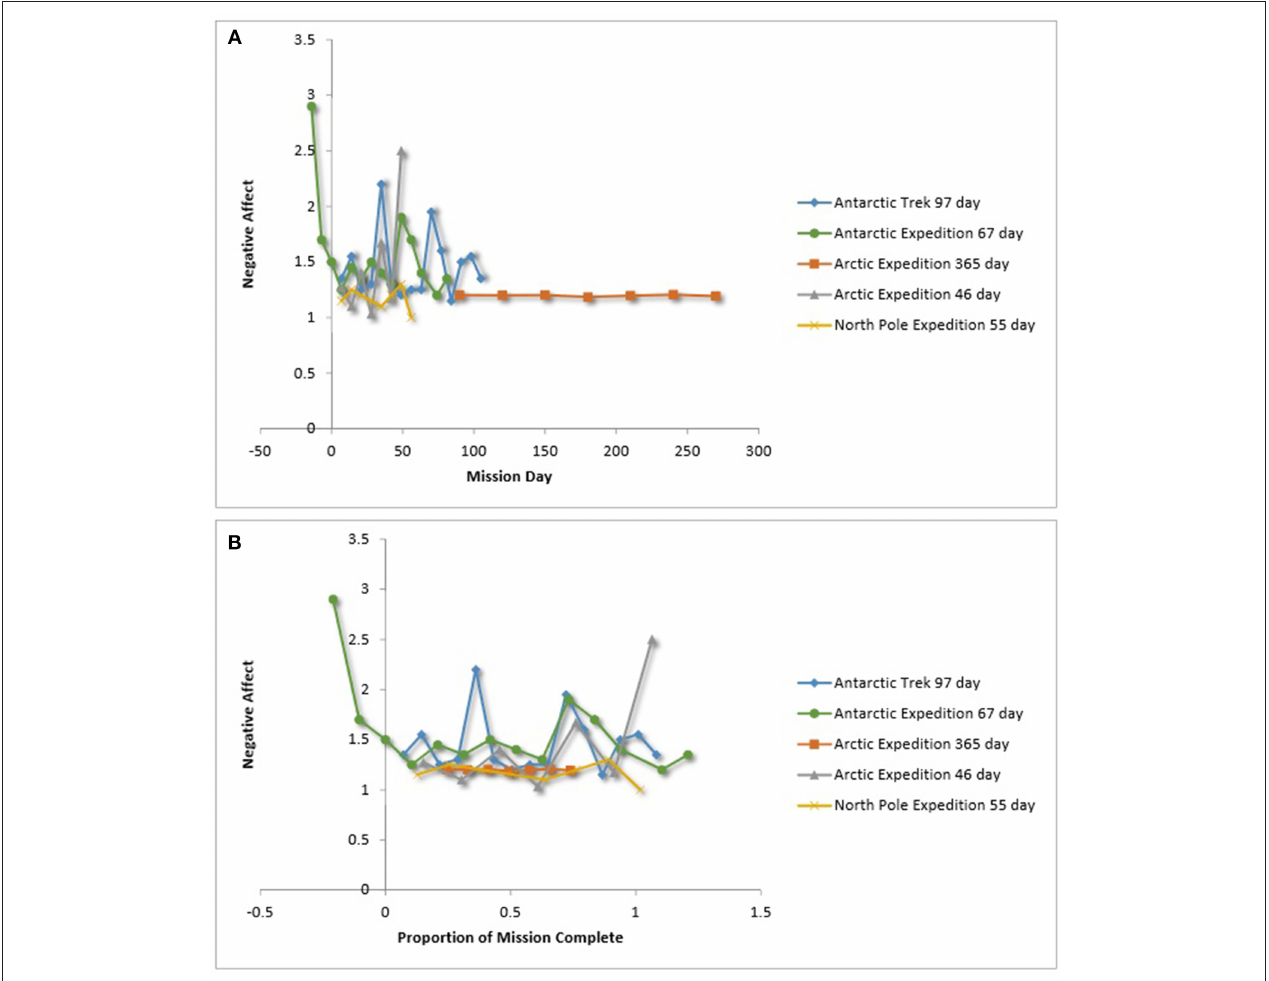
FIGURE 10 | (A) Team negative affect over time. (B) Team negative affect over time. Kahn and Leon (2000), Steel (2001), Atlis et al. (2004), Leon et al. (2004), Leon et al. (2011) , Nicolas et al. (2013). Binsted (2015) provided unpublished data that may be later published. Because of the level of granularity of these figures, the data are not